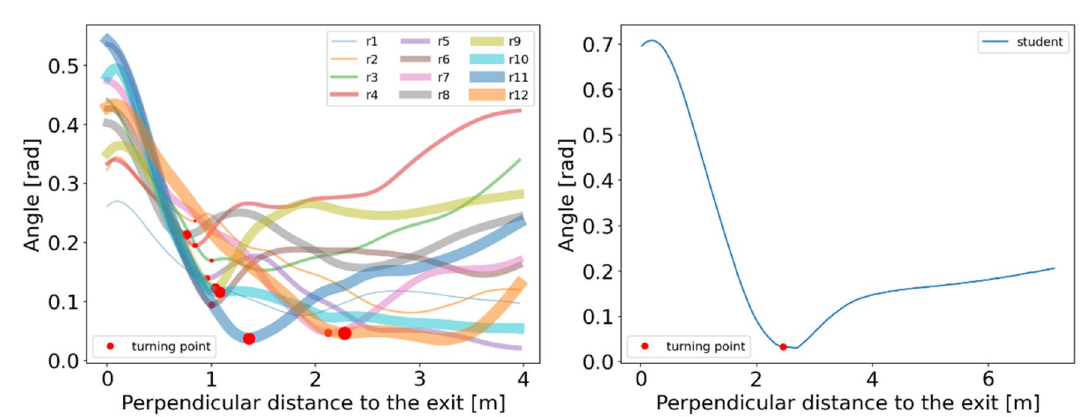
Figure 8. Relation between the movement direction and the distance perpendicular to the exit in children’s (Left) and students’ (Right) experiment. The colored lines represent the evolution of movement direction with the perpendicular distance. The red circles represent that pedestrians change their movement directions from the relatively smooth variation state to the rapid state. In the Left figure, to distinguish the experimental run, the linewidth and the size of the circles are